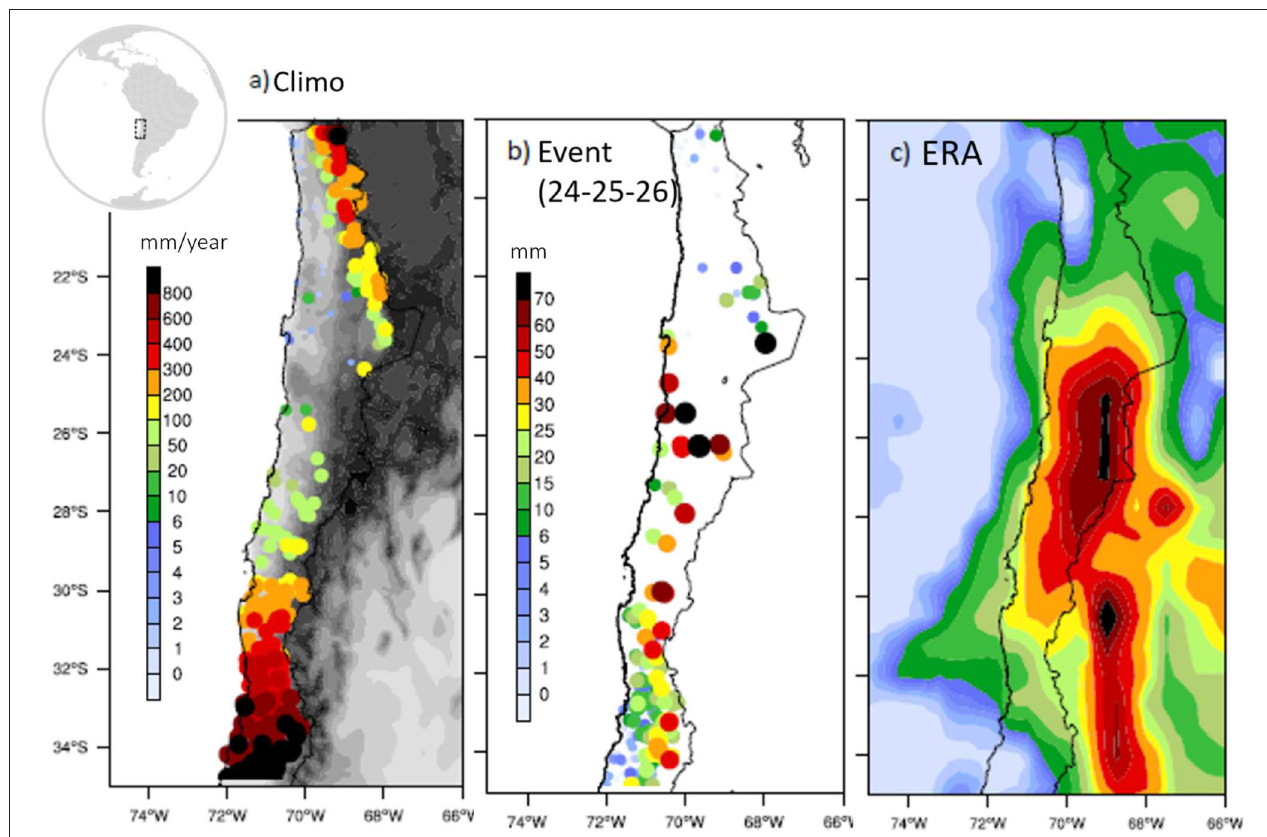
FIGURE 8 | (A) Annual mean precipitation along north-central Chile. (B) Station-records of accumulated precipitation during the Atacama storm (March 23–25, 2015). (C) ERA-5 analysis of accumulated precipitation during the Atacama storm (March 23–25, 2015). Note that the hyper-arid Atacama Desert is characterized by mean values below 5 mm/year but during the March 2015 storm some stations accumulated more than 70 mm in just three days. Based on data from Bozkurt et al.